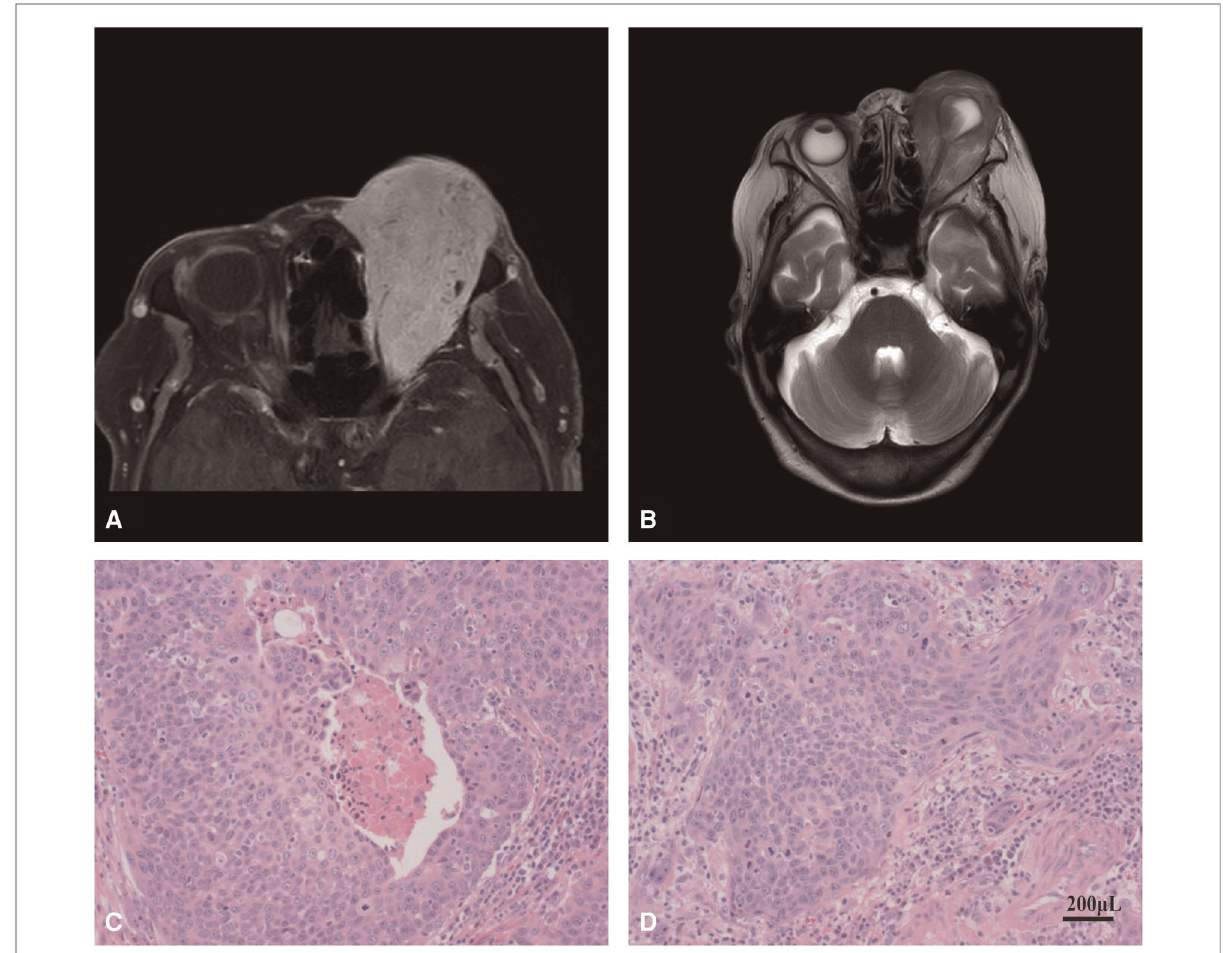
FIGURE 2 MRI examination and histopathological veri fi cation. ( A ) MRI examination of the patient ’ s orbit. ( B ) enhanced MRI of the patient ’ s orbit. ( C,D ), histopathological veri fi cation of tumor tissue in SCC